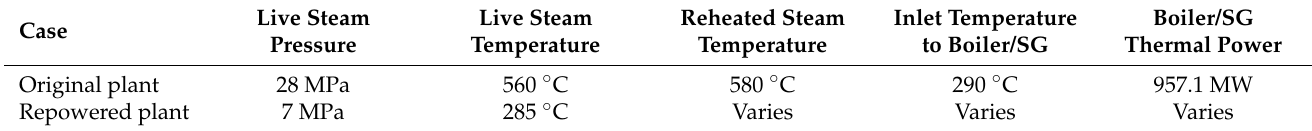
Table 1. Main assumptions for the original and repowered plant steam cycle.